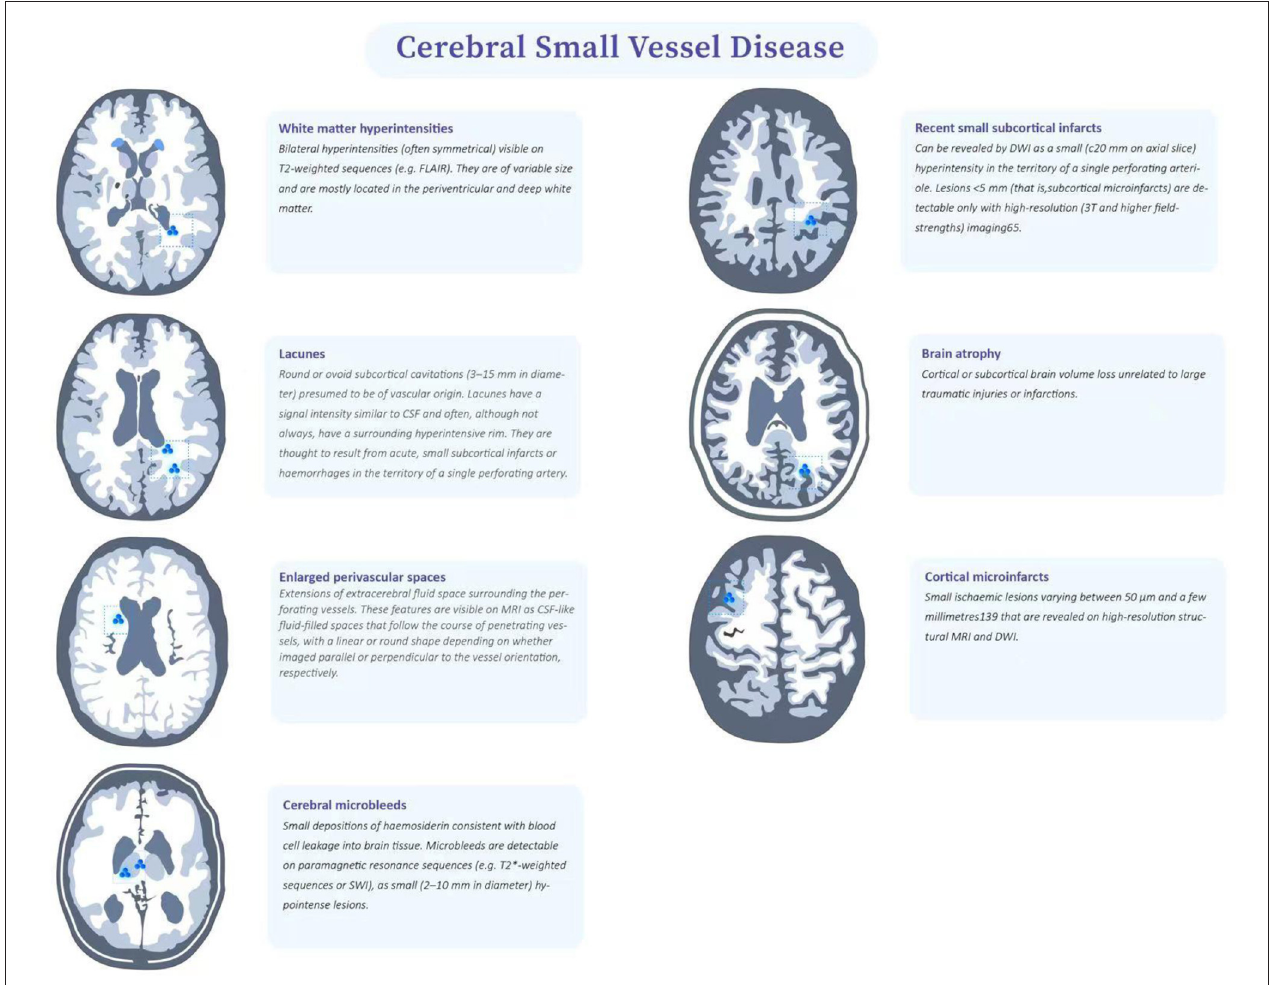
FIGURE 1 | Features of